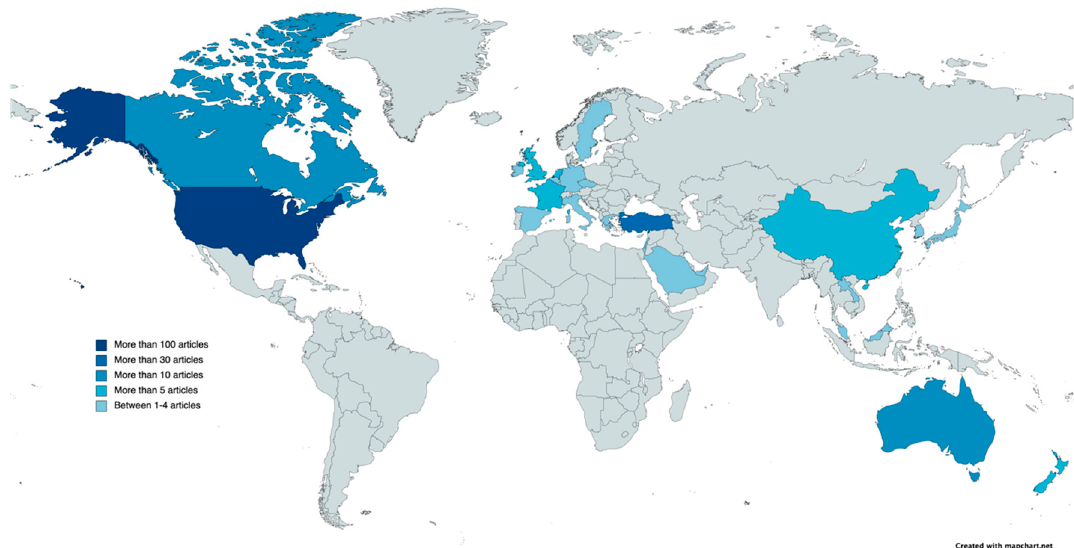
Figure 3. Number of articles published by country. Table 5. Journals by the number of publications and citations received (LCS and GCS) and Impact Factor